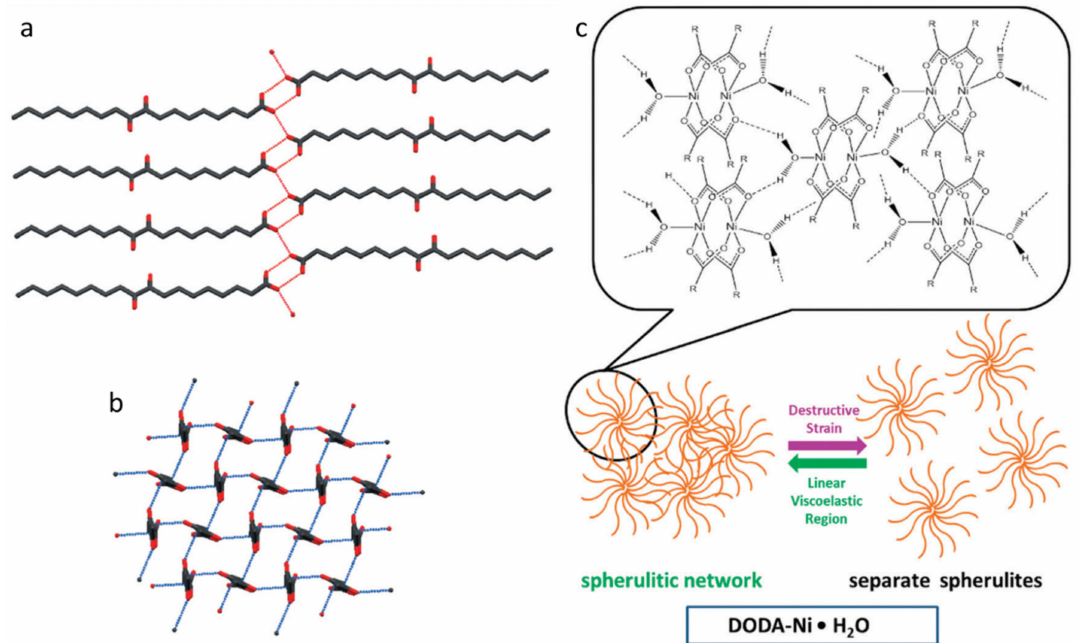
Figure 25. ( a ) 2D packing diagram of DODA viewed perpendicular to the polymethylene chains; the red dashed lines indicate the positions of H-bonds; ( b ) a 2D packing diagram of DODA viewed along the axis of the polymethylene chains; the blue dashed lines indicate dipole–dipole interactions. Reproduced from [44] with permission. Copyright John Wiley and Sons. ( c ) Schematic representation of proposed molecular packing arrangements and proposed mechanisms for mechano- destruction and reformation of self-assembled fibrillar networks in the DODA-Ni · H 2 O gels. Republished from [91] with permission of The Royal Society of